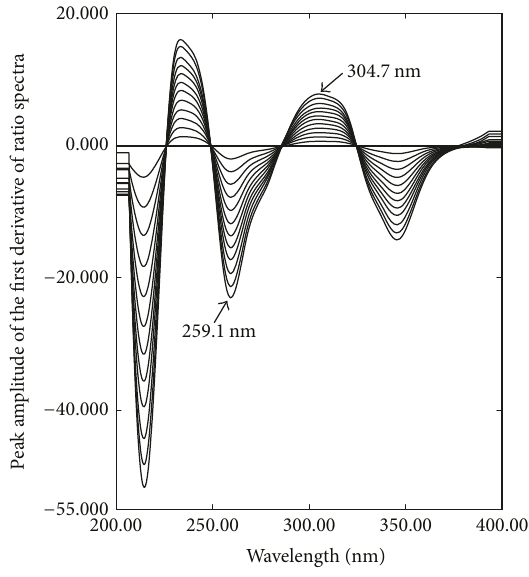
Figure7:FirstderivativeofratiospectraofFLU(5–60 𝜇 g/mL)using a normalized divisor of OXY and 0.1N HCl as a